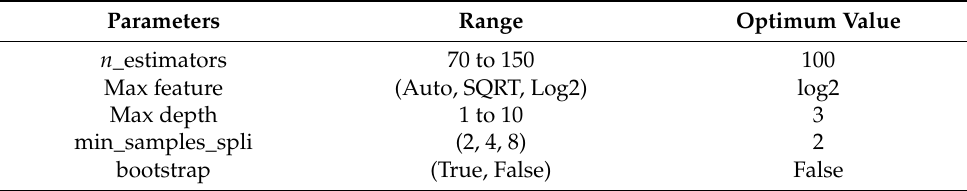
Table 3. Grid search hyperparameters for